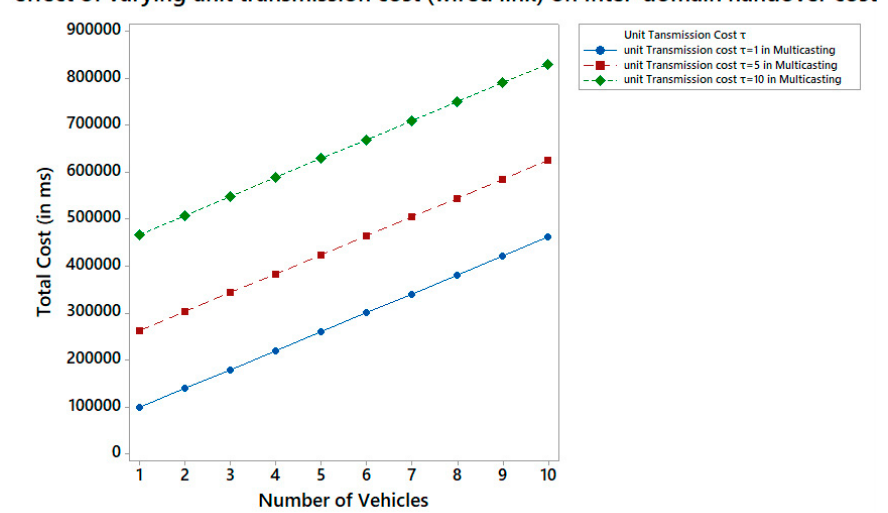
Figure 10. Effect of varying unit transmission cost (wired link) on inter-domain handoff .